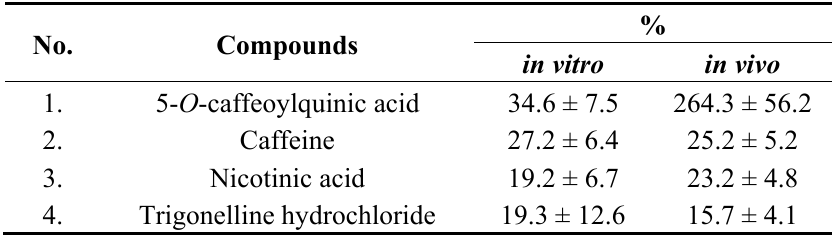
Table 8. Antiradical activity in vitro and in vivo of standard solutions of coffee biologically active components